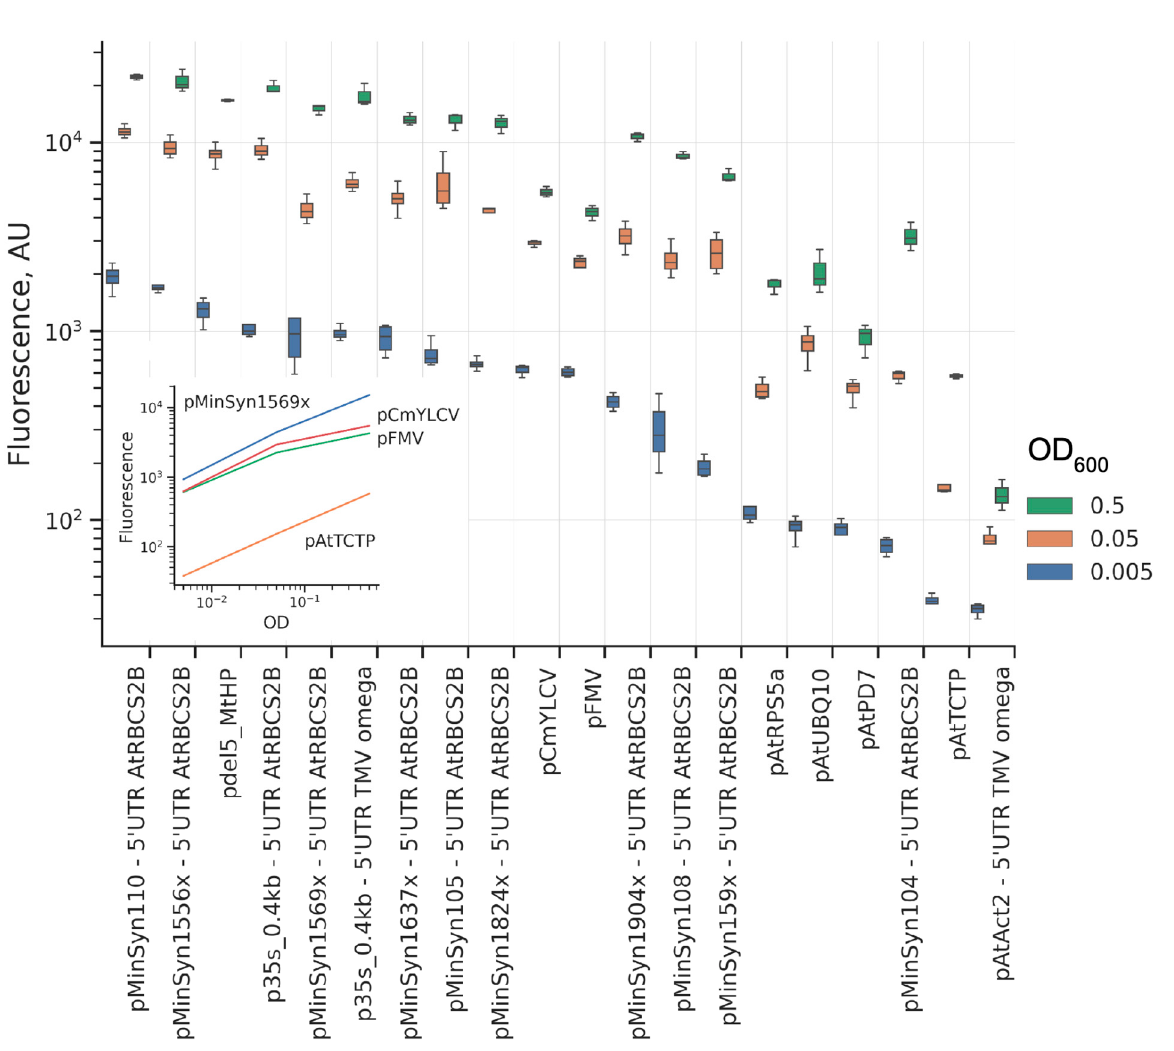
Figure 2. Effect of the gene dosage on the EGFP expression in BY-2 cell packs. The colors of the boxes correspond to the OD 600 of EGFP-carrying Agrobacterium upon inoculation: 0.5 (green), 0.005 (brown), and 0.0005 (blue). The order of promoters is based on level of fluorescence with OD 600 = 0.005 (from strong to weak); (inset) Representative log-log plots showing linear (pMinSyn1569x, pAtTCTP) and non-linear (pCmYLCV, pFMV) changes in fluorescence upon the increase in gene dosage. N = 4 cell packs were measured for each data point.